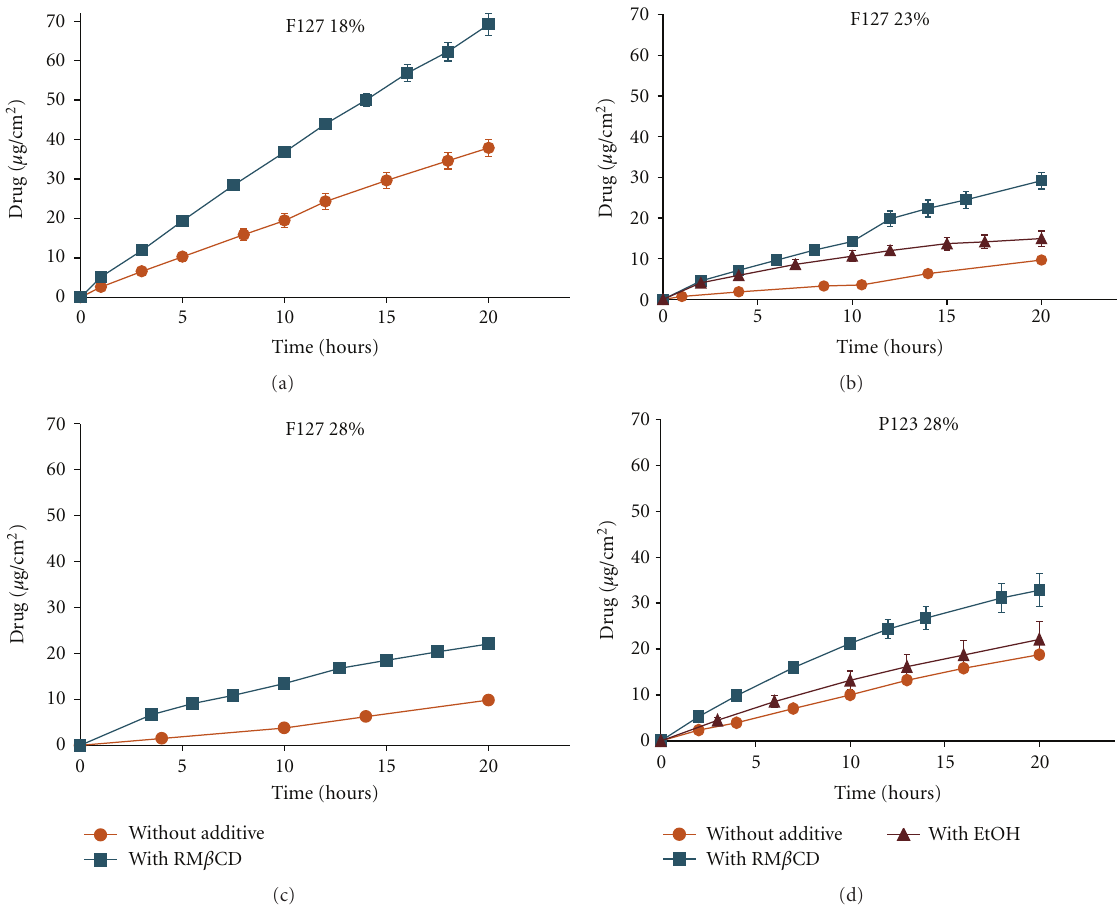
Figure 2: β LAP release profiles of Pluronic F127 and P123 systems formulated with and without additives.